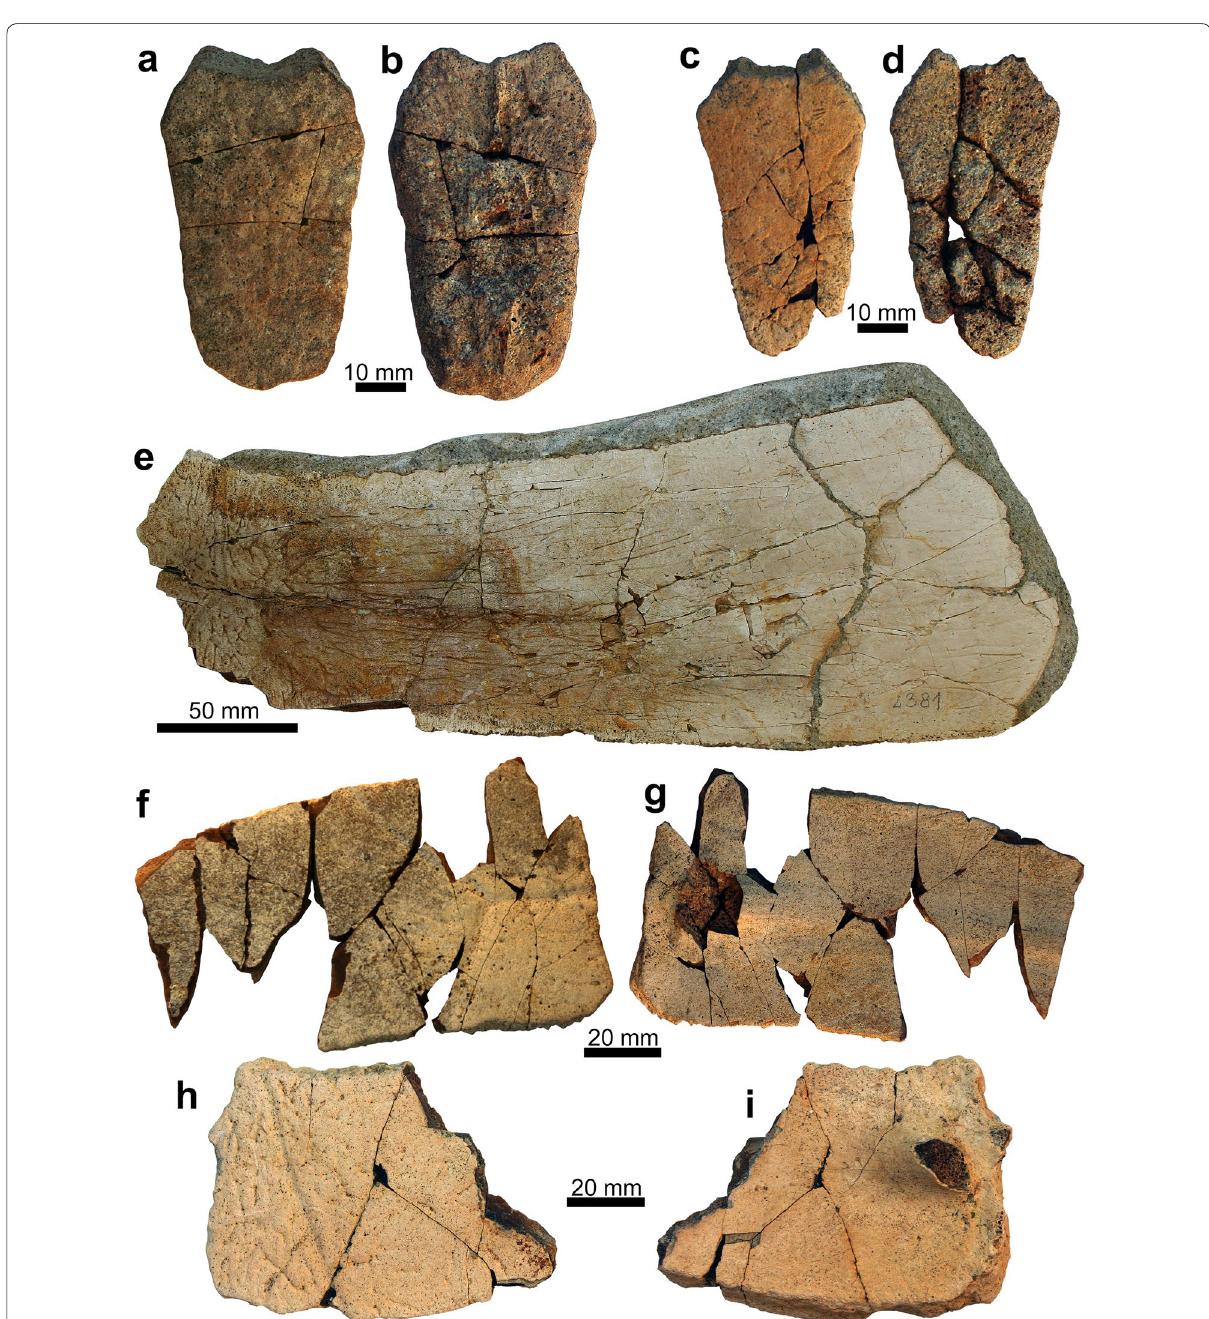
Fig. 3 Pan-Cheloniidae indet. from Cessaniti; carapace material. a – b Neural (MSNC 4592) in dorsal ( a ) and ventral ( b ) views; c – d neural (MSNC 4593) in dorsal ( c ) and ventral ( d ) views; e left costal (MSNC 4381) in dorsal view; f – g left costal (MSNC 4594) in dorsal ( f ) and ventral ( g ) views; h – i costal fragment (MSNC 4595) in dorsal ( h ) and ventral ( i )